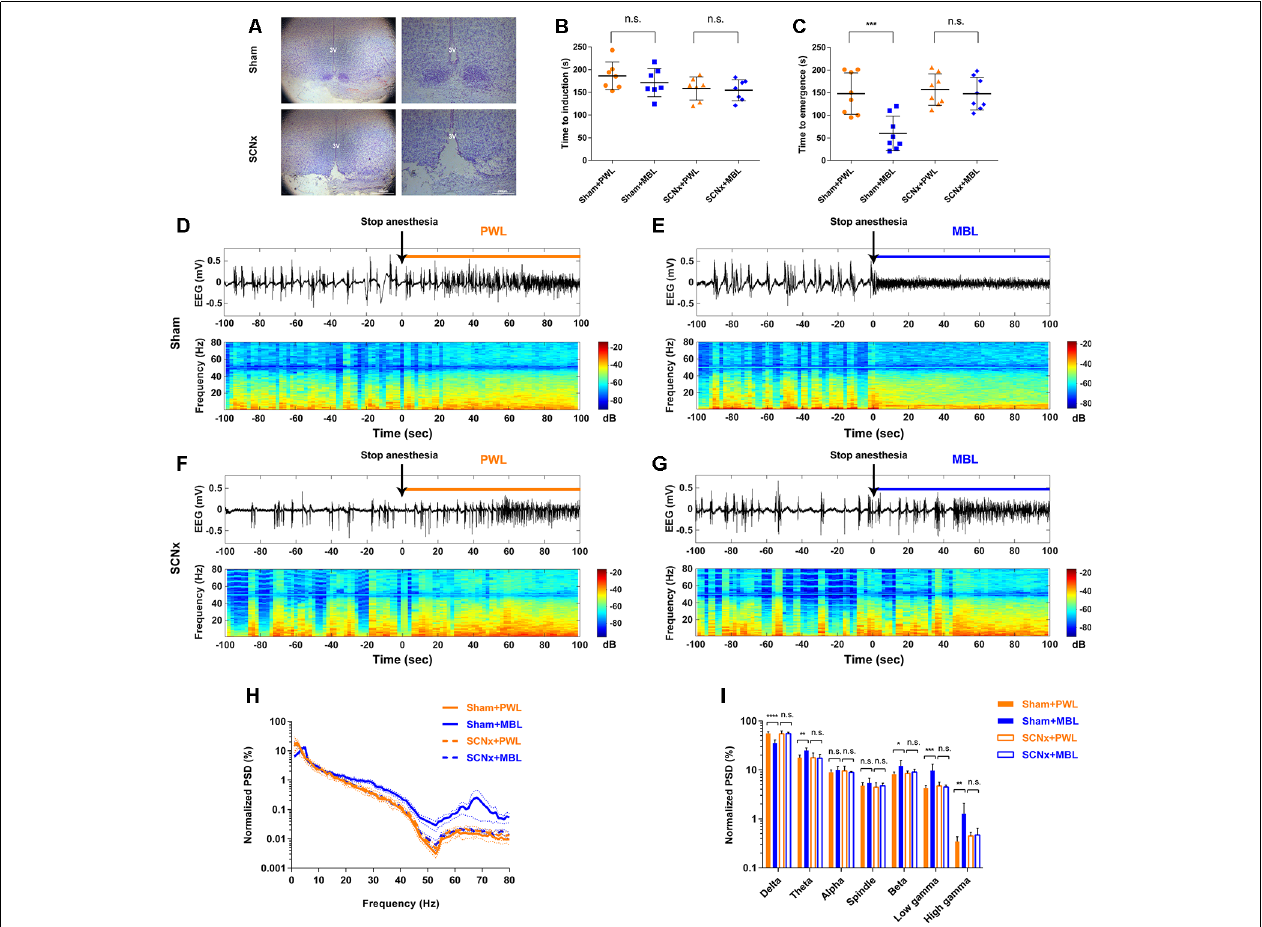
FIGURE 4 | Lesion of SCN neurons abolished MBL-induced arousal-promoting responses during sevoflurane anesthesia. (A) Nissl-stained coronal brain sections of the SCN are shown for the sham (upper) and SCN lesioned (lower) animals. 3V, third ventricle. Scale bar = 200 µ m. (B) Results of the sevoflurane-inducing LORR time in the sham and SCNx groups (SCN lesioned), both of which received PWL or MBL, respectively. The sham animals treated with MBL showed no statistically significant difference in induction time relative to the sham-PWL mice (PWL, 186.10 ± 30.67 s vs. MBL, 171.30 ± 31.01 s) in sevoflurane anesthesia. The SCNx animals treated with MBL did not show a significant difference in induction times relative to those treated with PWL (158.40 ± 25.41 s vs. MBL, 154.60 ± 23.23 s) (n.s. = not significant, n = 7 in each group, F (3,24) = 1.848, ordinary one-way ANOVA, and Tukey’s multiple comparisons test). (C) The sham animals treated with MBL showed a significant decrease in recovery time relative to the sham-PWL mice (PWL, 147.90 ± 46.01 s vs. MBL, 60.13 ± 37.84 s) in sevoflurane anesthesia. The SCNx animals treated with MBL did not show a significant difference in recovery times relative to those treated with PWL (PWL, 156.80 ± 34.85 s vs. MBL, 147.60 ± 35.96 s; *** p < 0.001 compared with sham PWL, n.s. = not significant, n = 8 in each group, F (3,28) = 10.94, ordinary one-way ANOVA, and Tukey’s multiple comparisons test). Data are expressed as mean ± SD. (D–G) Representative electroencephalogram traces (upper) and electroencephalogram power spectrogram (lower) in the sham (D,E) and SCNx groups (SCN lesioned; F,G) , both of which received PWL or MBL, respectively. Time 0 indicates stopping sevoflurane anesthesia and the beginning of light stimulation. The orange and blue lines indicate the 100 s intervals used for power spectral density comparisons. (H) Normalized group PSD from the sham PWL (orange solid line), sham MBL (blue solid line), SCNx PWL (orange dotted line), and SCNx MBL (blue dotted line) groups. (I) The sham animals treated with MBL showed a significant decrease in the relative electroencephalogram delta power and an increase in the theta, beta, low gamma, and high gamma power compared to the sham-PWL mice. The SCNx animals treated with MBL showed no significant difference in electroencephalogram power relative to those treated with PWL (* p < 0.05, ** p < 0.01, *** p < 0.001, and **** p < 0.0001 compared with sham PWL, n.s. = not significant, n = 6 in each group, ordinary one-way ANOVA, and Tukey’s multiple comparisons test). Data are expressed as mean ± SD. PWL, polychromatic white light; MBL, monochromatic blue